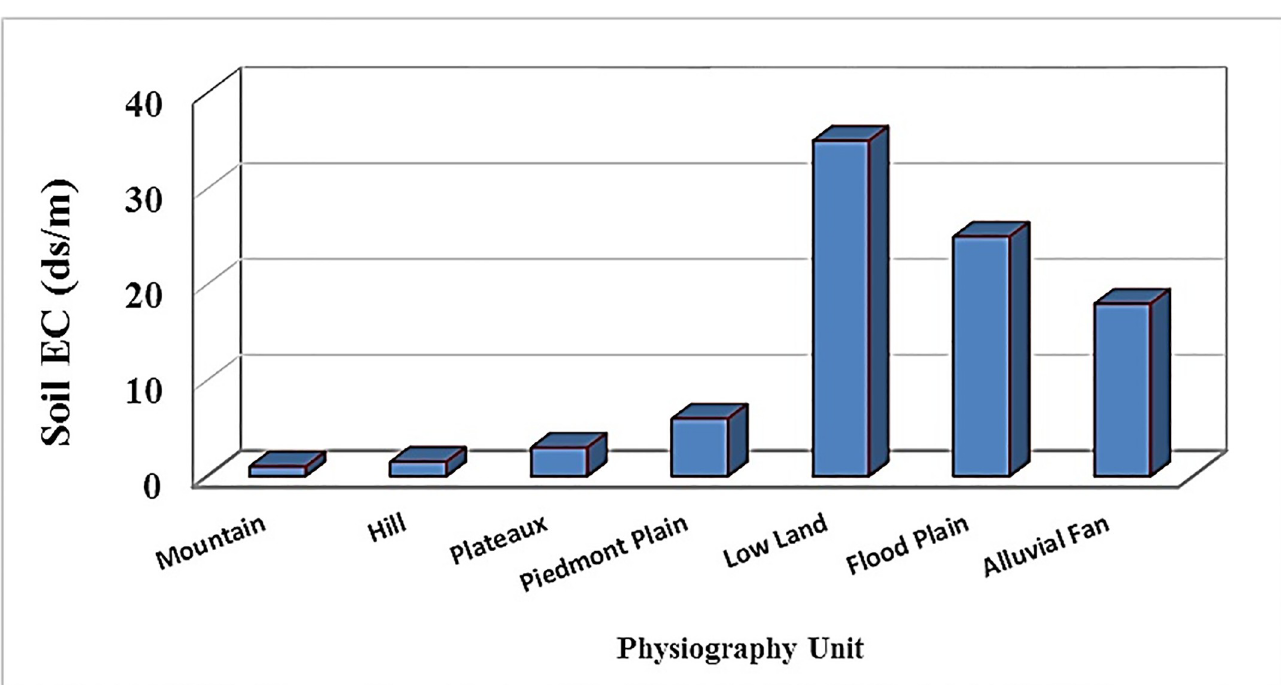
Fig 6. Soil salinity mean value in physiography units of the study area, Lowlands are distinguished by maximum observational salinity and mountains are minimum observational salinity.